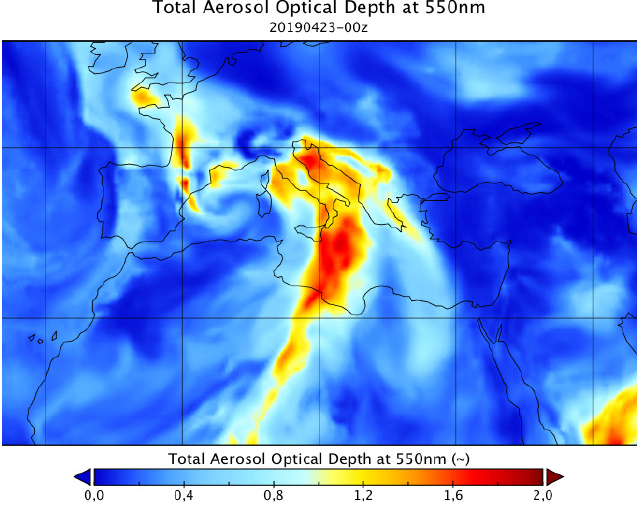
Figure 14. Total Aerosol Optical Depth (AOD) at 550 nm, at 00 UTC on 23rd April. The maps are generated using Copernicus Atmosphere Monitoring Service Information